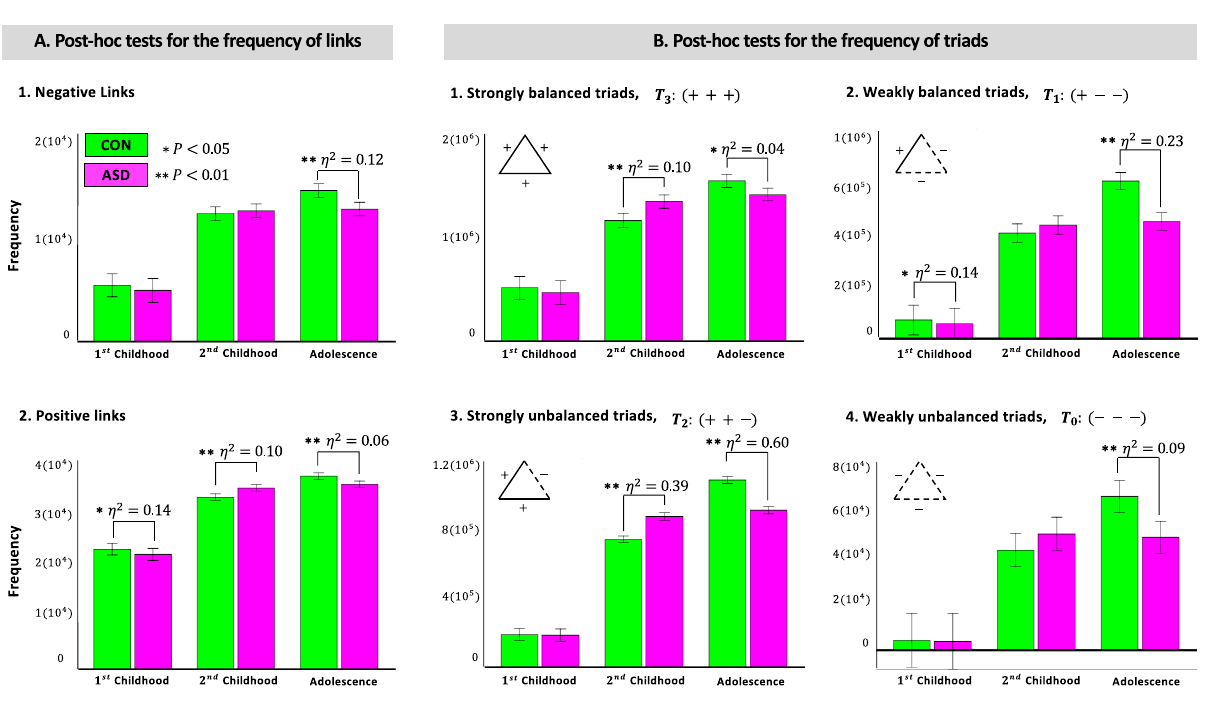
Figure 1. Mann-Whitney U test on the frequency of links and triads. ( A ) Difference between ASD and CON 2 ≥ 0.14 ) groups is only practically significant (η for the mean frequency of positive links during 1st childhood. ( B ) Yet, considering triads provides us with practical differences not only during 1st childhood but also during 2nd childhood and adolescence. η 2 , the effect size; CON, control; ASD, autism spectrum disorder (Color